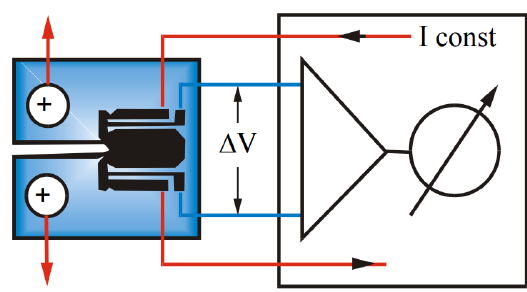
Figure 5. Scheme of measurement foil and crack growth detection [9] The relationship between the fatigue crack